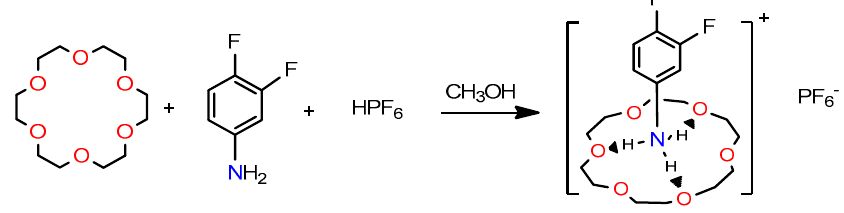
Scheme 1. Synthesis process and structural diagrams of 1 .